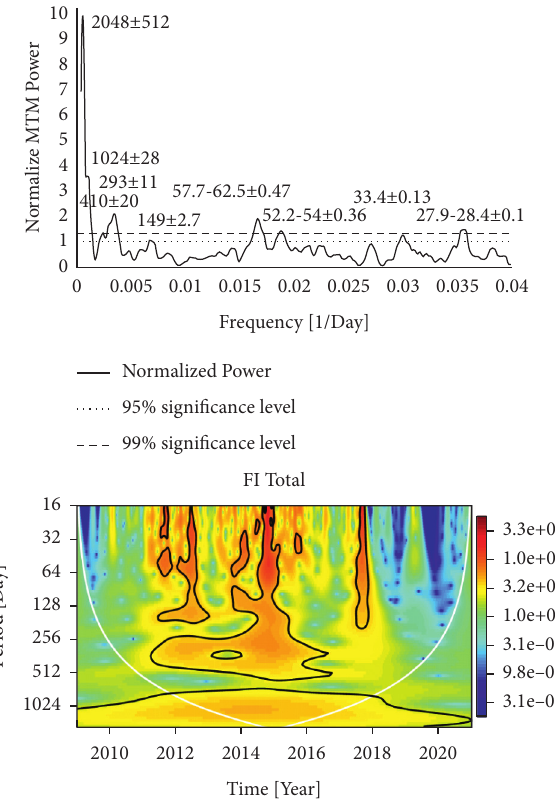
Figure 4: MTM (upper panel) and Morlet wavelet (lower panel) analysis results for whole disk FI data for the investigated time interval. White solid line in the wavelet scalogram shows the cone of influence (COI); black solid lines show the significant periodicities. Table 1: Detected periods, their existence, and significance level in each data set used in this study. Period